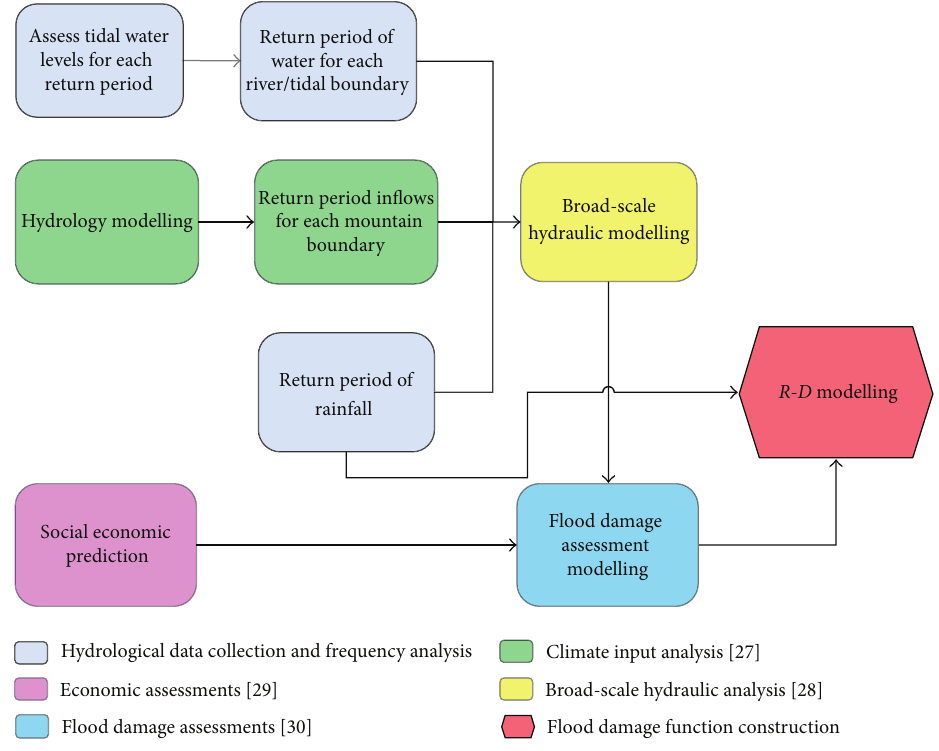
Figure 3: Basic framework of flood risk analysis [24].